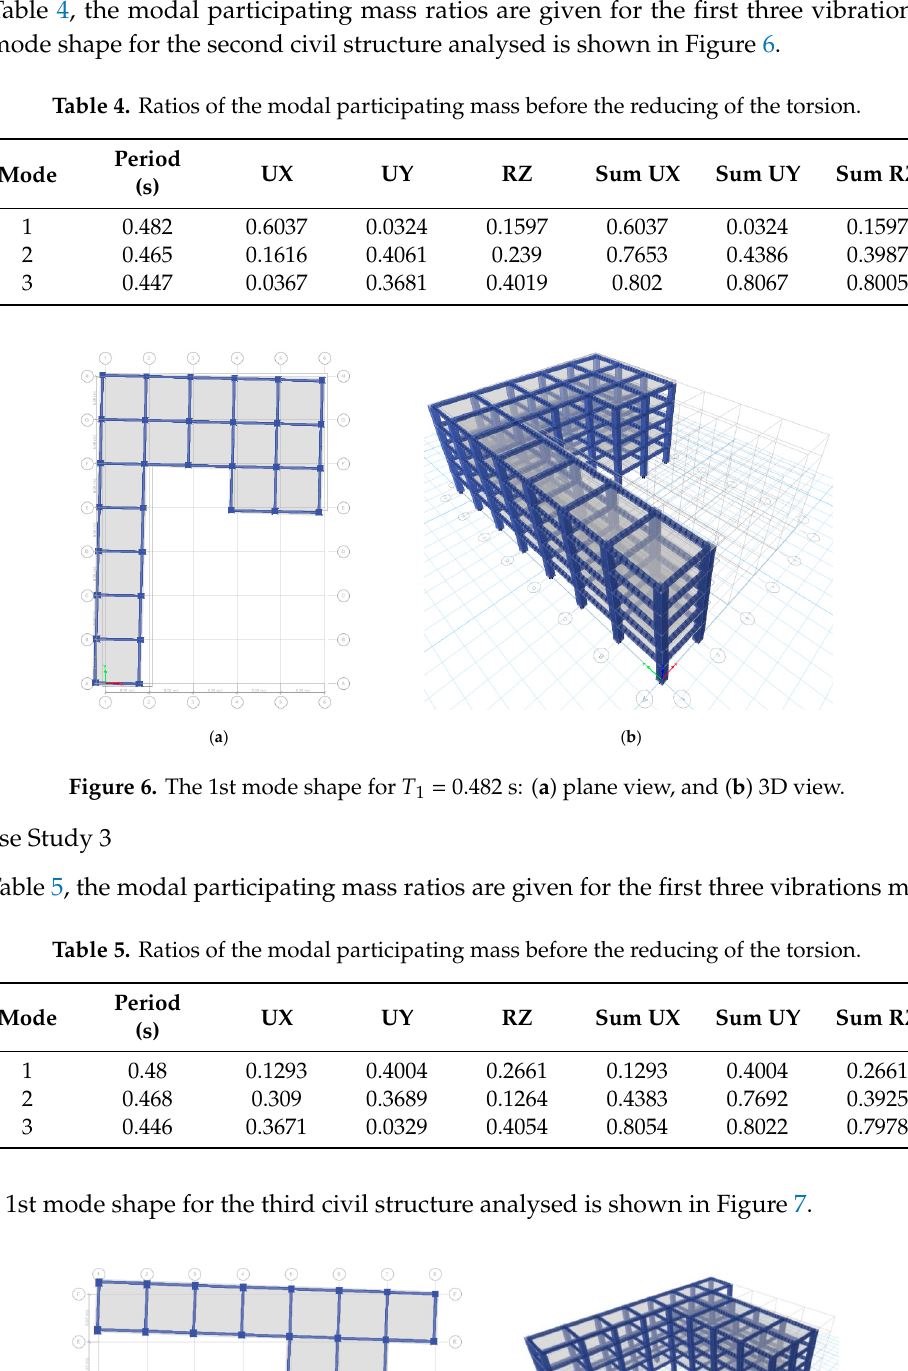
( b ) Figure 8. The 1st mode shape for T 1 = 0.481 s: ( a ) plane view, and ( b ) 3D view. 4. Results 4.1. Reduction of Torsion Effect for the Structures In this section, mathematical and practical solutions to reduce the effect of torsion for the four cases presented in Section 3.2 are shown. For every situation, the optimization process undergoes expressions (27) and (29), and the results of the calculus are presented, for which a modal analysis was performed.